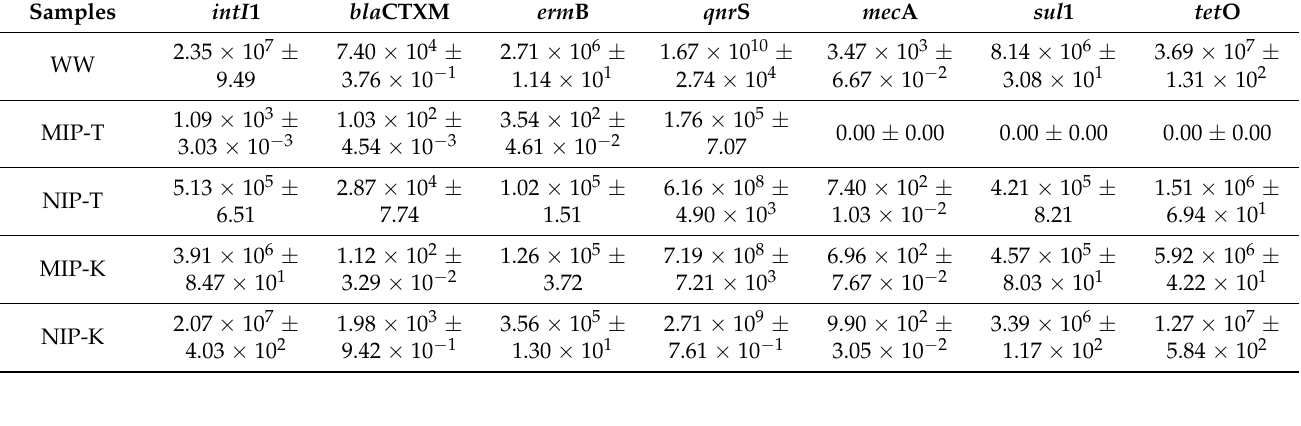
Table 2. qPCR quantified ARG abundance in copy numbers with standard error of means in 100 mL of WW, untreated and treated with the novel nanomaterials, namely MIP-T (LPS-MIP in tandem with QAS-K), NIP-T (NIP in tandem with QAS-K), MIP-K (MIP with kaolin) and NIP-K (NIP with kaolin). Samples